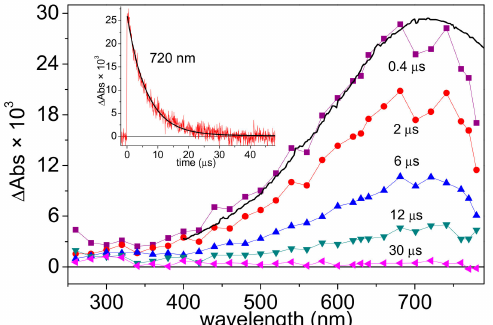
Figure 3. Laser flash photolysis (LFP) of 50 mM sulfite at pH 9.5 in argon-saturated solution. Transient absorption spectra at di ff erent time delays after excitation. The solid line is the literature spectrum of e aq − taken from [29]. Insert:kinetic curve at 720 nm with the first-order best fit with lifetime 8 µ